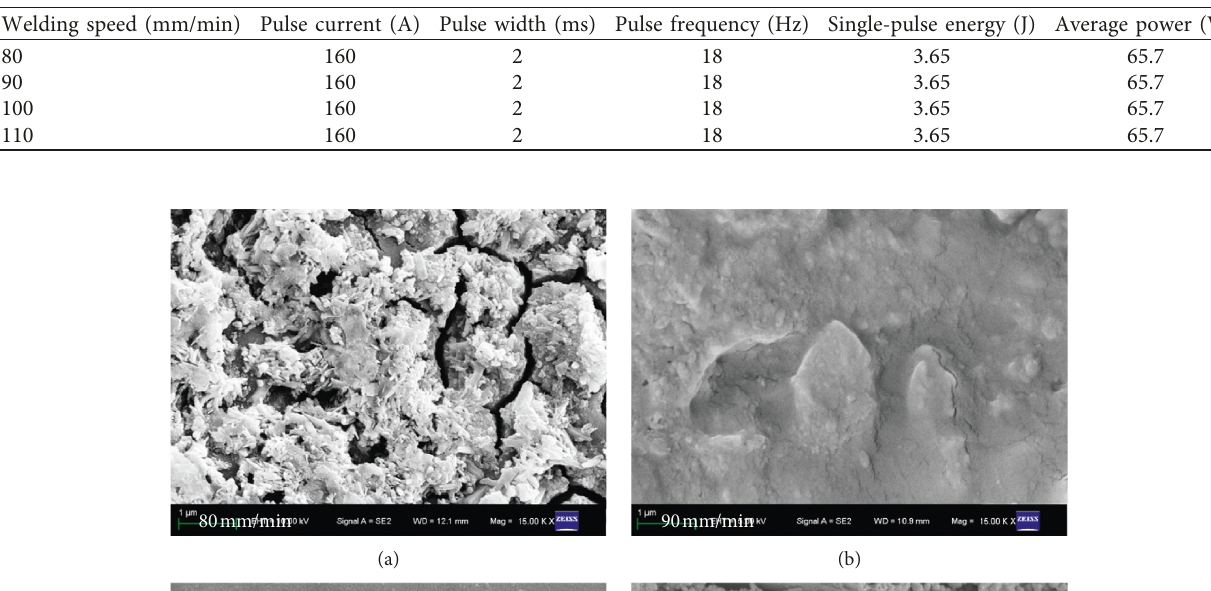
Table 1: Welding process parameters when changing welding speed.